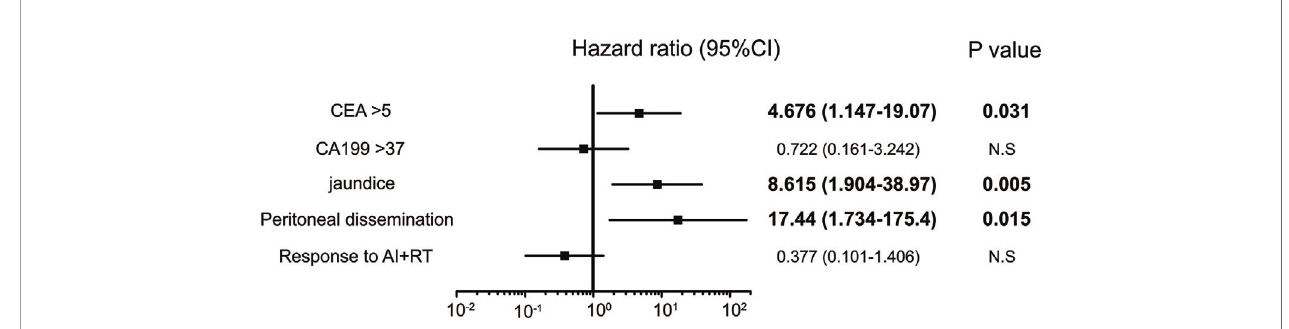
FIGURE 4 | Signi fi cant independent prognostic factors of gallbladder cancer (GBC). The CEA value, jaundice and peritoneal dissemination were signi fi cant prognostic factors in the multivariate analysis. Peritoneal dissemination had the highest HR at 17.4.